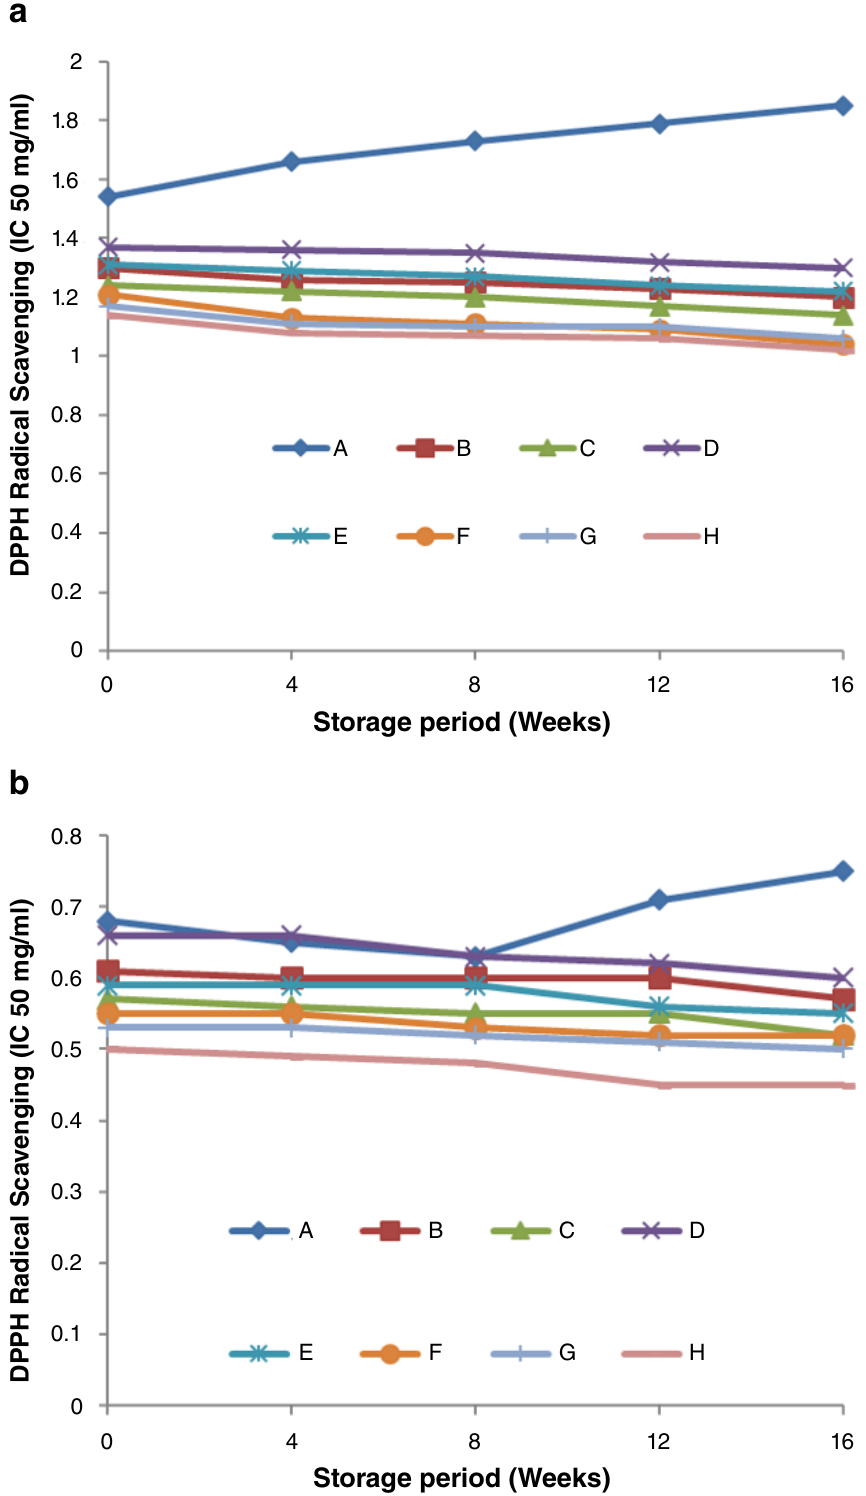
Figure 4. DPPH Radical Scavenging Activity Ogi flour made with ( a ) maize and ( b ) sorghum with Garlic or Ginger. Sample codes: A: Ogi Flour, B: Ogi Flour + 2% Garlic, C: Ogi Flour + 4% Garlic, D: Ogi Flour + 2% Ginger, E: Ogi Flour + 4% Ginger, F: Ogi Flour +2% Garlic + 2% Ginger, G; Ogi Flour+2% Garlic + 4% Ginger, H: Ogi Flour +4% Garlic + 2%